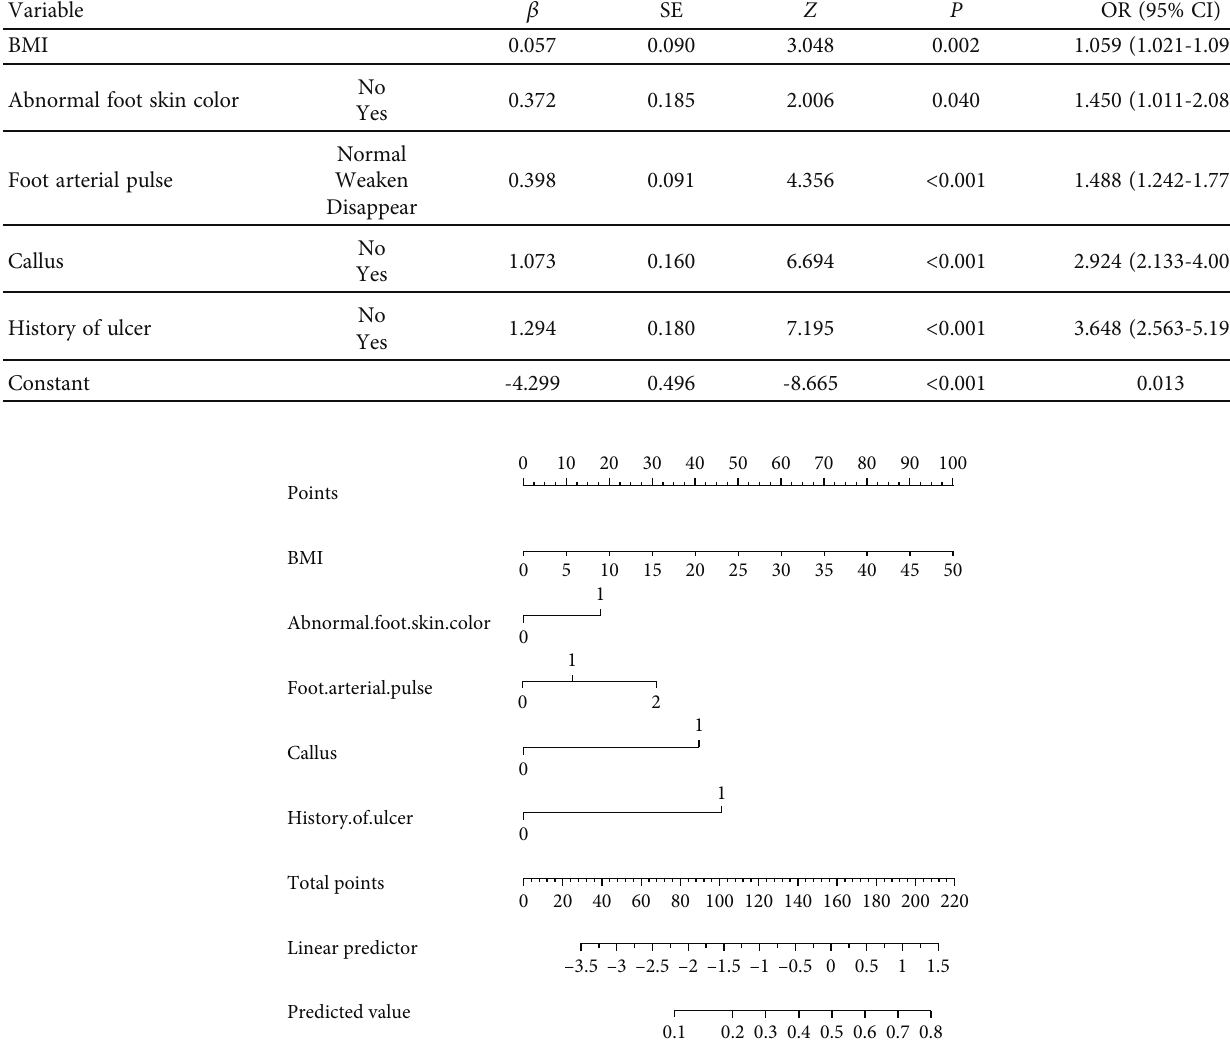
Figure 2: Nomogram of the risk prediction model for foot ulcers in diabetic